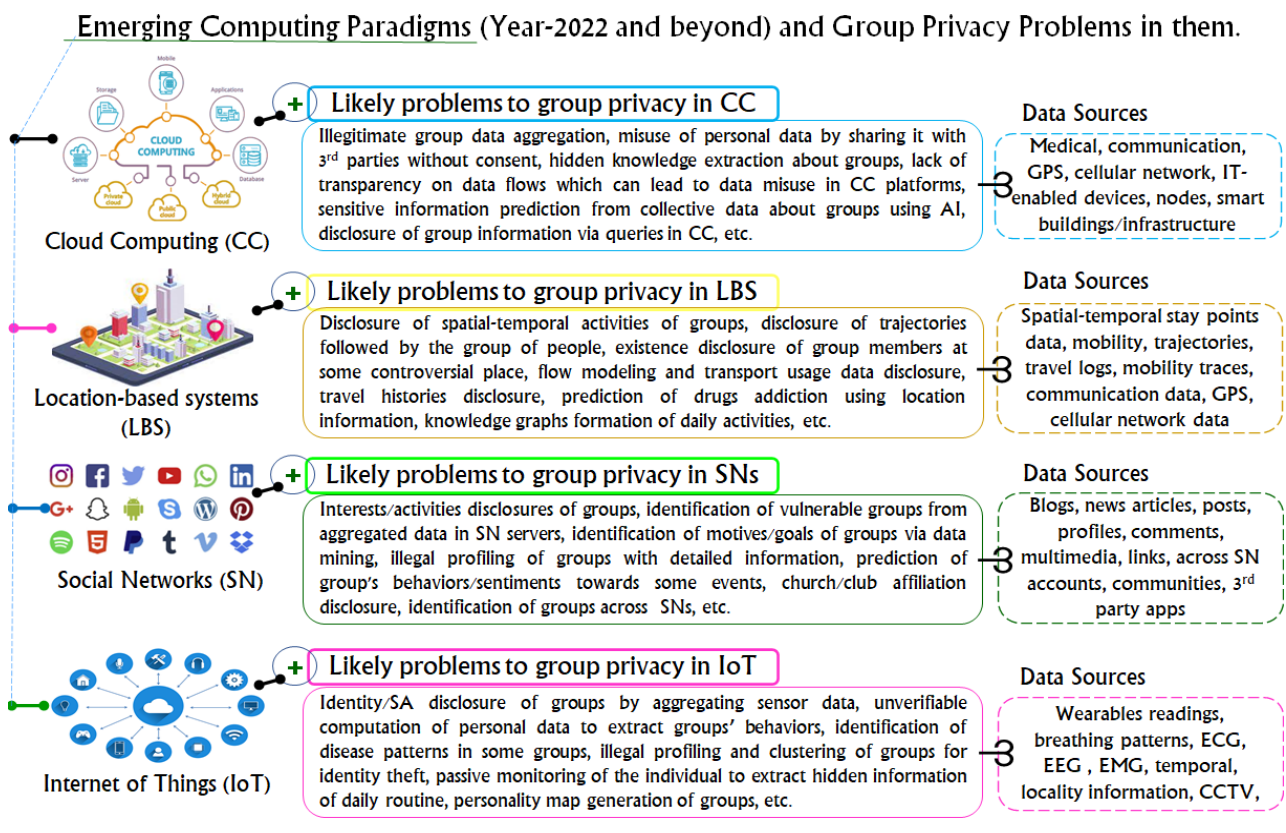
Figure 18. Likely group privacy problems in emerging computing